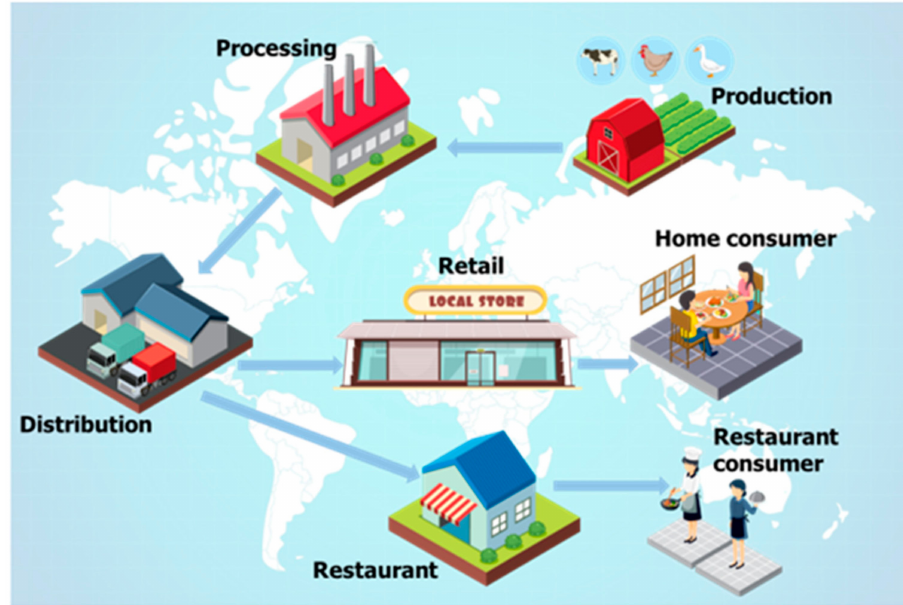
Figure 1. Food contamination chain (all graphical illustrations were created using materials from the free images database: